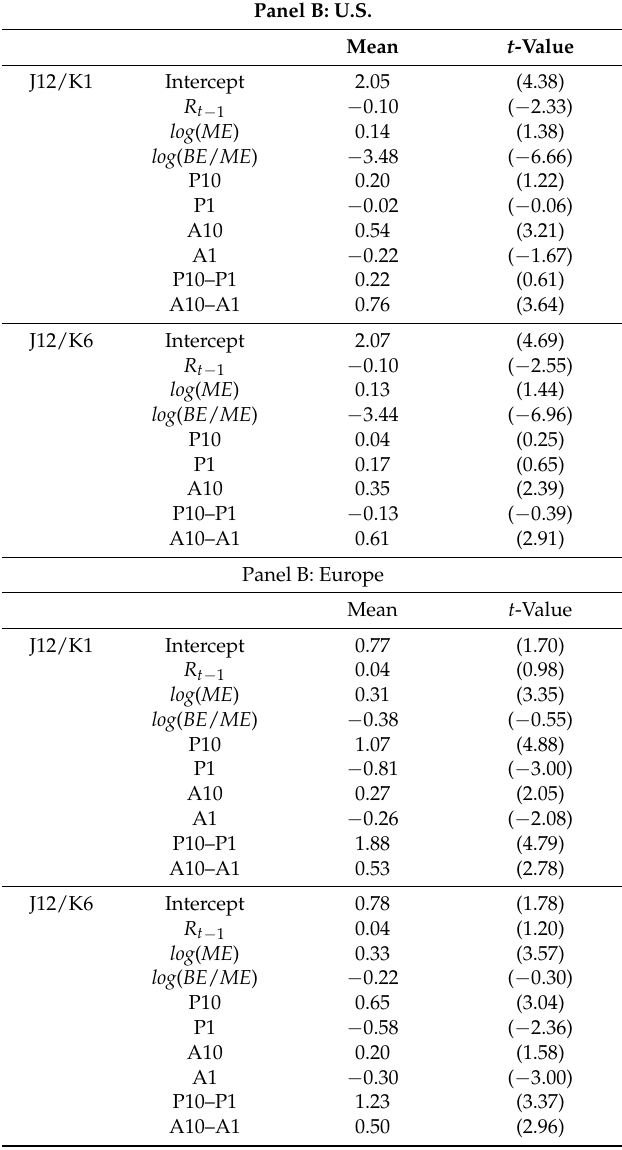
Table 5. Dominance of momentum strategies in the cross-section of individual stock returns. Panel B: